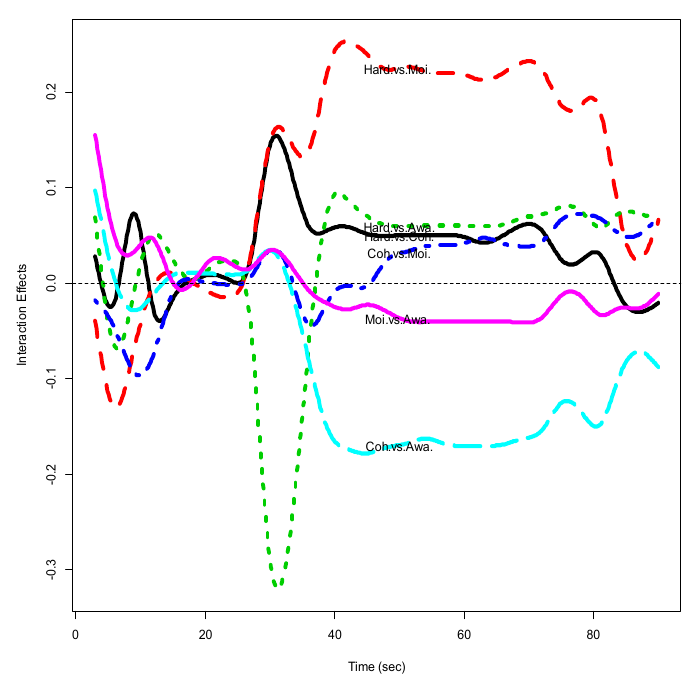
Figure 7. Temporal drivers of Overall Liking of Texture with line scale (interaction).